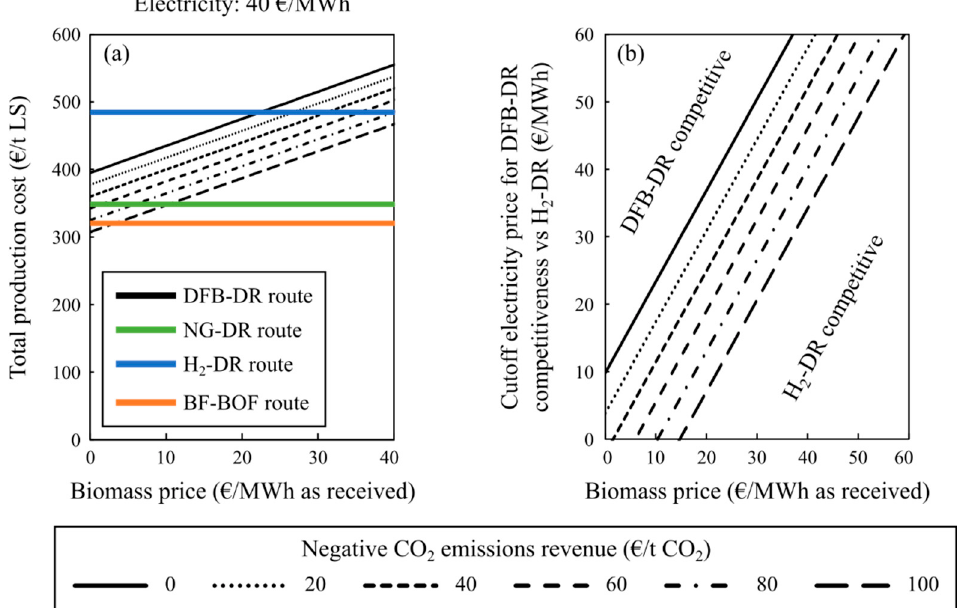
Figure 7. Total production cost of the various routes, and cutoff electricity price for which the DFB-DR route is competitive compared with the H 2 -DR route. ( a ) Total production costs (in EUR/t liquid steel) for the three DR routes and the traditional BF–BOF route (value from Vogl et al. [47]), as a function of the biomass price (in EUR/MWh) and the revenue associated with negative CO 2 emissions (EUR/t CO 2 ), for an electricity price of 40 EUR/MWh. The various lines for the DFB-DR route correspond to the revenues accrued from negative CO 2 emissions, ranging from 0 EUR/t (top line) to 100 EUR/t (bottom line), with the dashed lines indicating increments of 20 EUR/t. The DFB-DR case is based on the “Median” cost estimation for the CAPEX of the DFB unit and the gas-handling section. ( b ) Cutoff electricity price, above which the DFB-DR route is more competitive economically than the H 2 -DR route, for various revenues from negative CO 2 emissions. The biomass price is on an as-received basis for a moisture content of 40%.